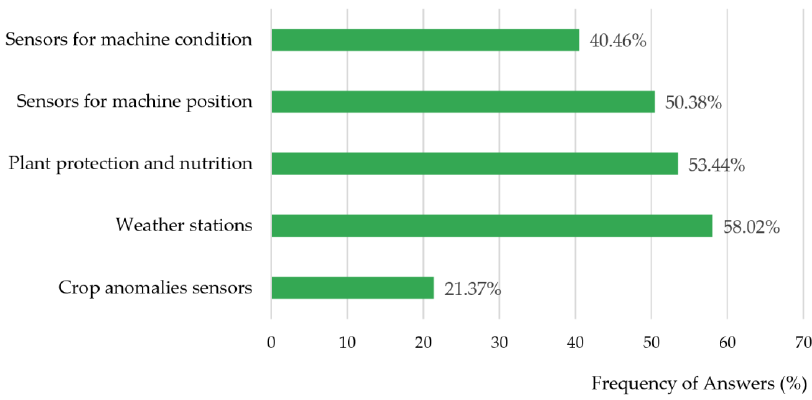
Figure 1. Use of sensors in crop production.